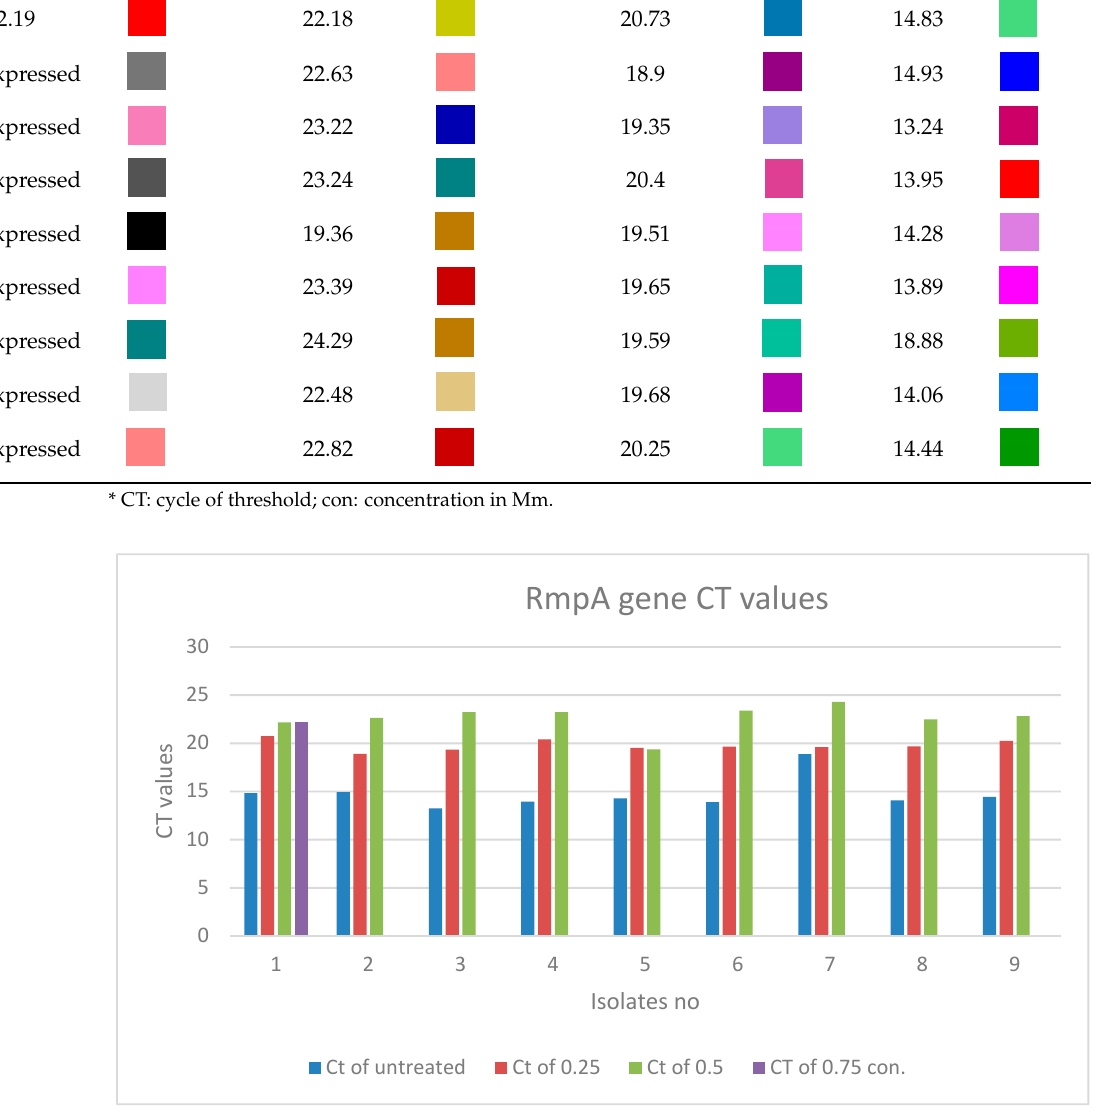
Figure 7. rmpA gene expression in Klebsiella pneumoniae isolates treated with different concentrations of ZnO NPs.